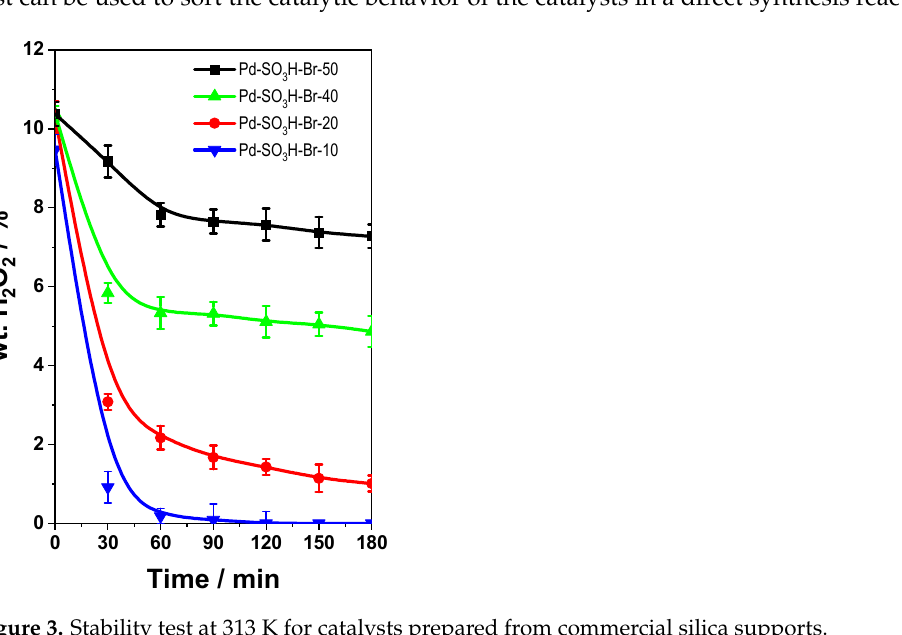
Figure 3. Stability test at 313 K for catalysts prepared from commercial silica supports.